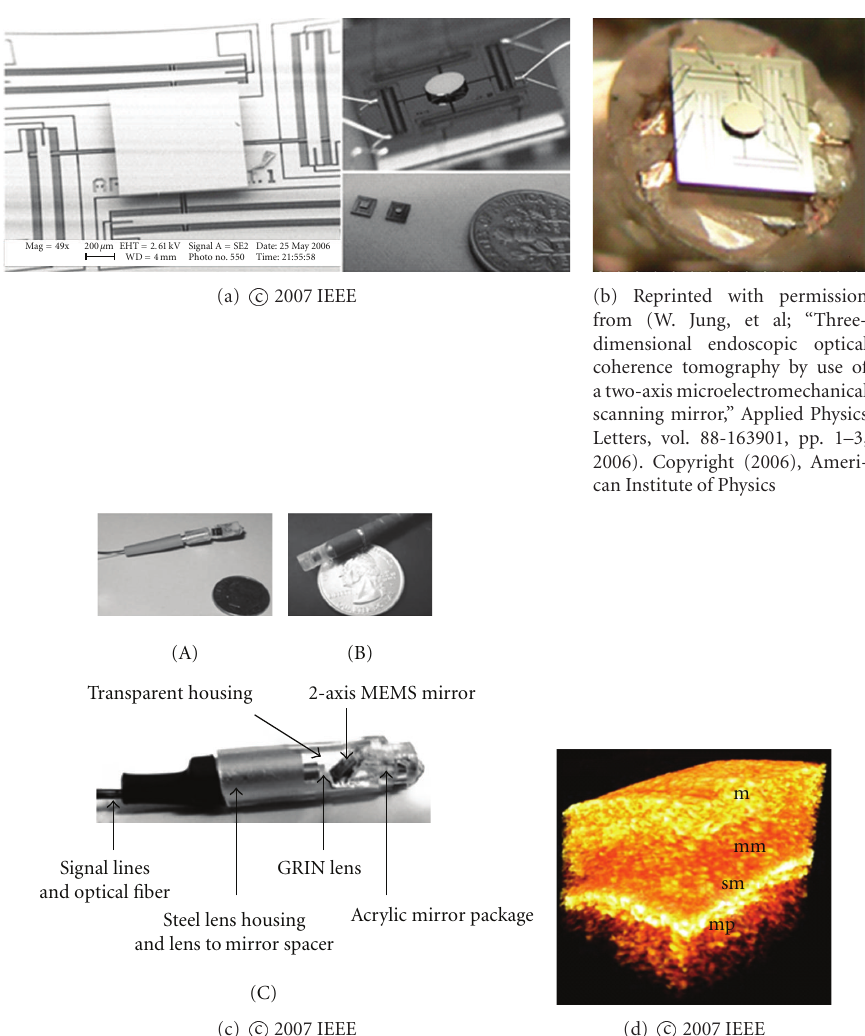
Figure 3: Electrostatic MEMS OCT from UC-Irvine/UC-Berkeley. (a) SEMs of two MEMS mirrors, (b) Electrical connection through wire bonding, (c) packaged MEMS probe, (d) 3D image of rabbit rectal